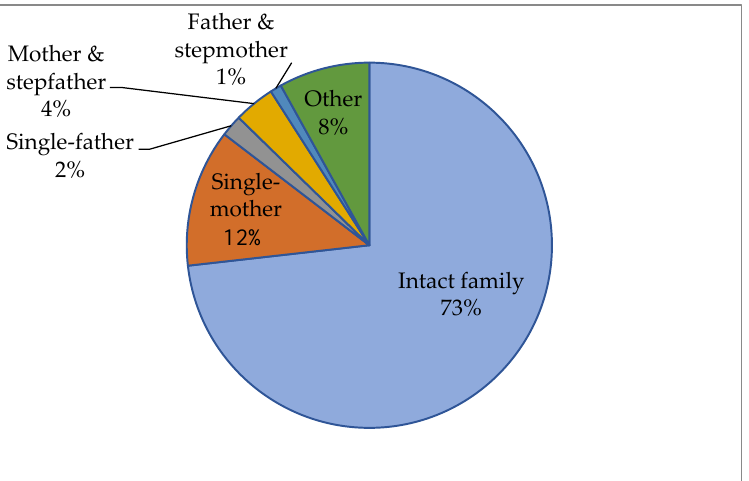
Figure 2. Average family structure, according to the HBSC survey conducted in 44 countries in 2018. Data were weighted by the country’s sample size.